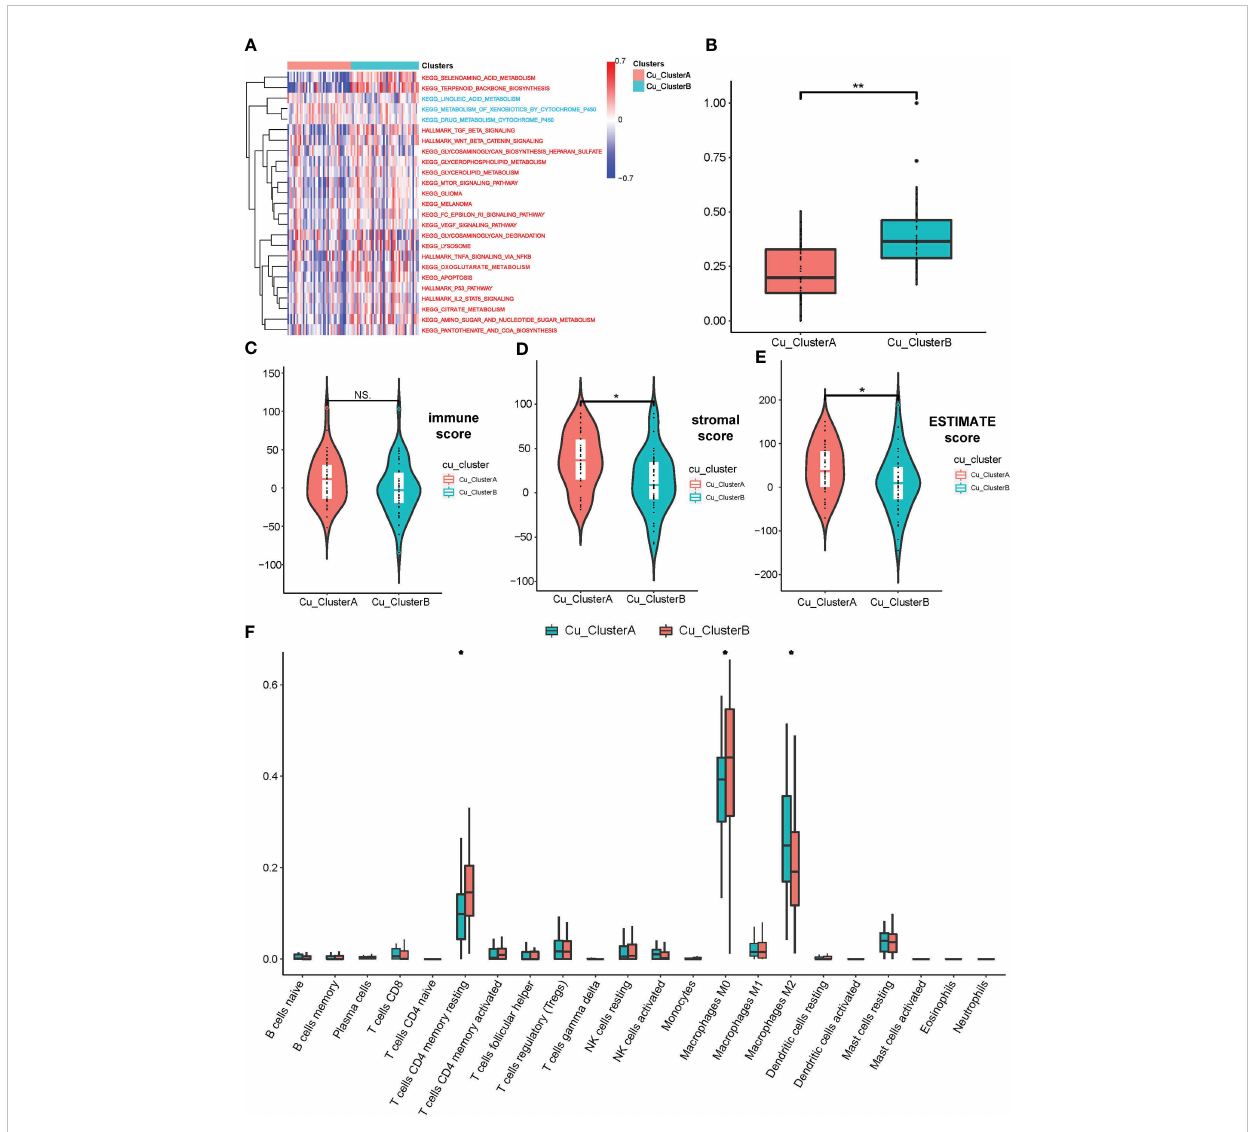
FIGURE 2 OS samples in different Cu_Clusters exhibited distinct tumor biological characteristics. (A) GSVA analysis showed diverse enriched pathways in different Cu_Clusters. (B) Divergence in the mRNAsi index showed differences in stemness properties between Cu_ClusterA and Cu_ClusteB. (C – E) ESTIMATE analysis for the overall status of immune cell in fi ltration and stromal component samples in the TARGET_OS dataset. (F) ssGSEA for the in fi ltration analysis of 29 types of immune cells in different Cu_Clusters *P < 0.05; **P <